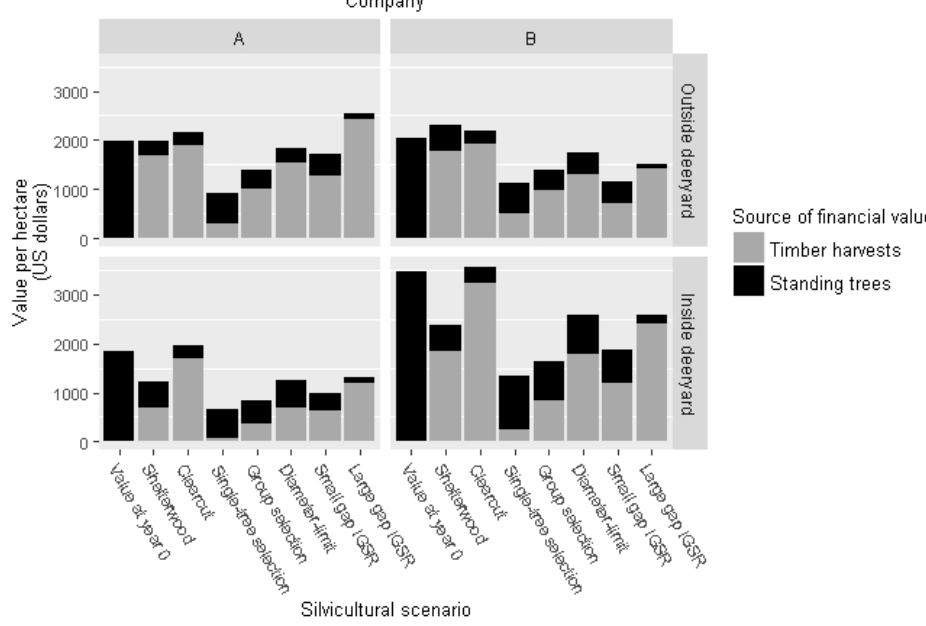
Figure 2. Simple financial returns per hectare of modeled management scenarios of two companies ( A , B ). The scenarios included activities both outside deeryards (top row of graphs) and inside deeryards (bottom row of graphs) separately, due to differences in the starting conditions. Each bar represents the total value of the trees on one hectare for a given management option and is composed of harvest revenue (total returns from all entries within 50 years with the first entry at year 0; grey portion of bar) and standing value (stumpage value of standing timber at the end of the 50-year simulation; black portion of bar). The first bar in each panel represents the value of the starting inventory tree list before any harvests were modeled. “IGSR” represents the irregular group shelterwood with reserves system. Data in Appendix A.